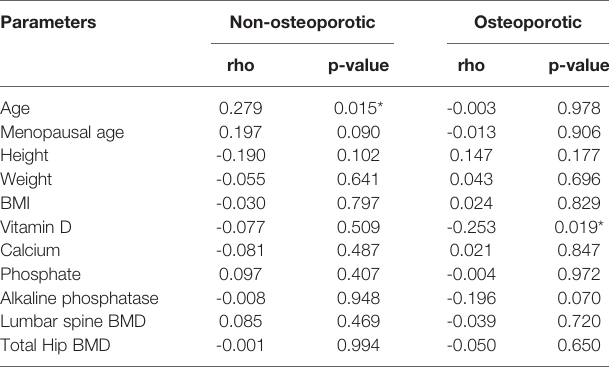
TABLE 2 | Correlation of serum resistin levels with anthropometric measures, biochemical parameters, and BMD in postmenopausal non-osteoporotic and osteoporotic females using spearman ’ s rho correlation coef fi cient. Parameters